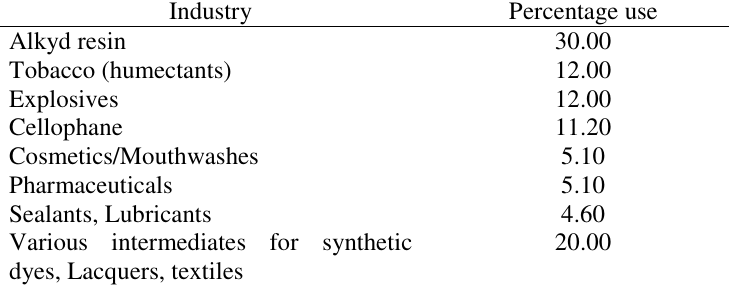
Table 1. Estimated consumption of glycerin in various industries 11